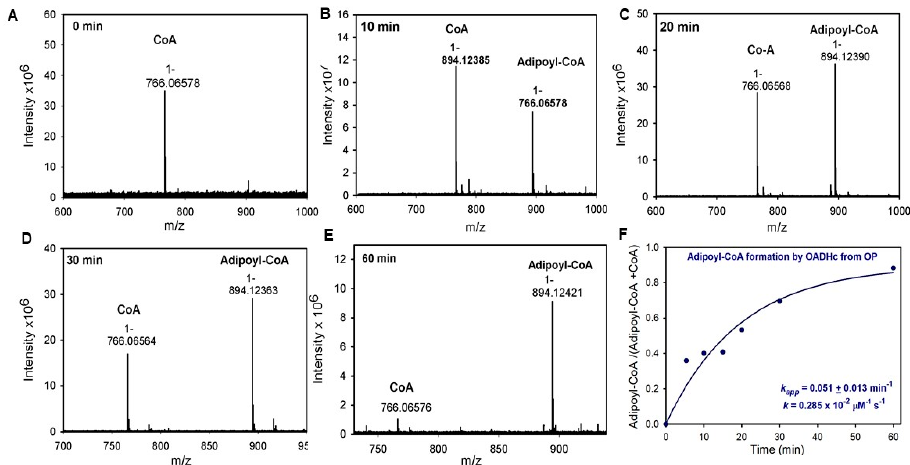
Figure 3. Time-dependent formation of the adipoyl-CoA product by FT-MS. ( A – E ) The FT-MS spectra of CoA and adipoyl-CoA detected in the reaction assay with OADHc and 2 mM OP. ( F ) Time-dependence of the fraction of adipoyl-CoA formed. The fraction of adipoyl-CoA versus total CoA (CoA plus adipoyl-CoA) estimated based on the relative peak heights intensities was plotted against time and enabled calculation of k app of adipoyl-CoA formation and the second-order rate constant. The data points were fit to a single exponential equation (y = y o + a × (1 − e − kt )), and the line is the regression fit trace. The value of k app ± standard error is presented. See Methods for experimental conditions and data treatment.